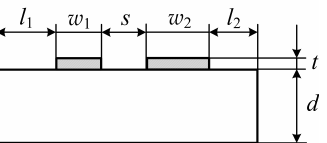
Figure 5. Rectangular geometry of a slot line